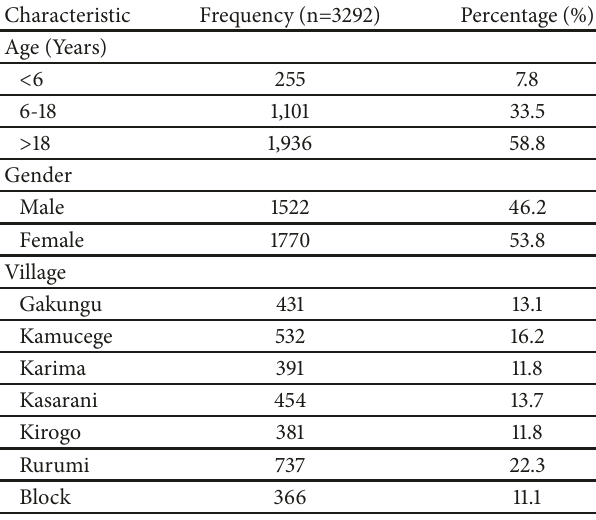
Table 1: Demographic characteristics of the study